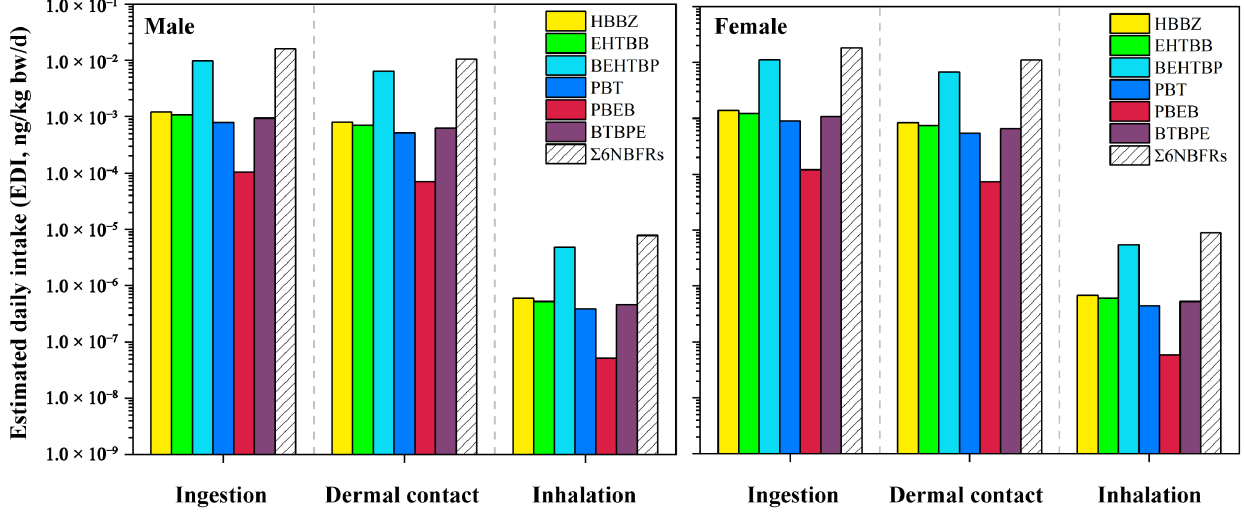
Figure 4. The occupational exposure of NBFRs in the e-waste-dismantling workshop (DW1, average exposure scenario) via dust pathways of ingestion, dermal contact, and inhalation. exposure scenario) via dust pathways of ingestion, dermal contact, and